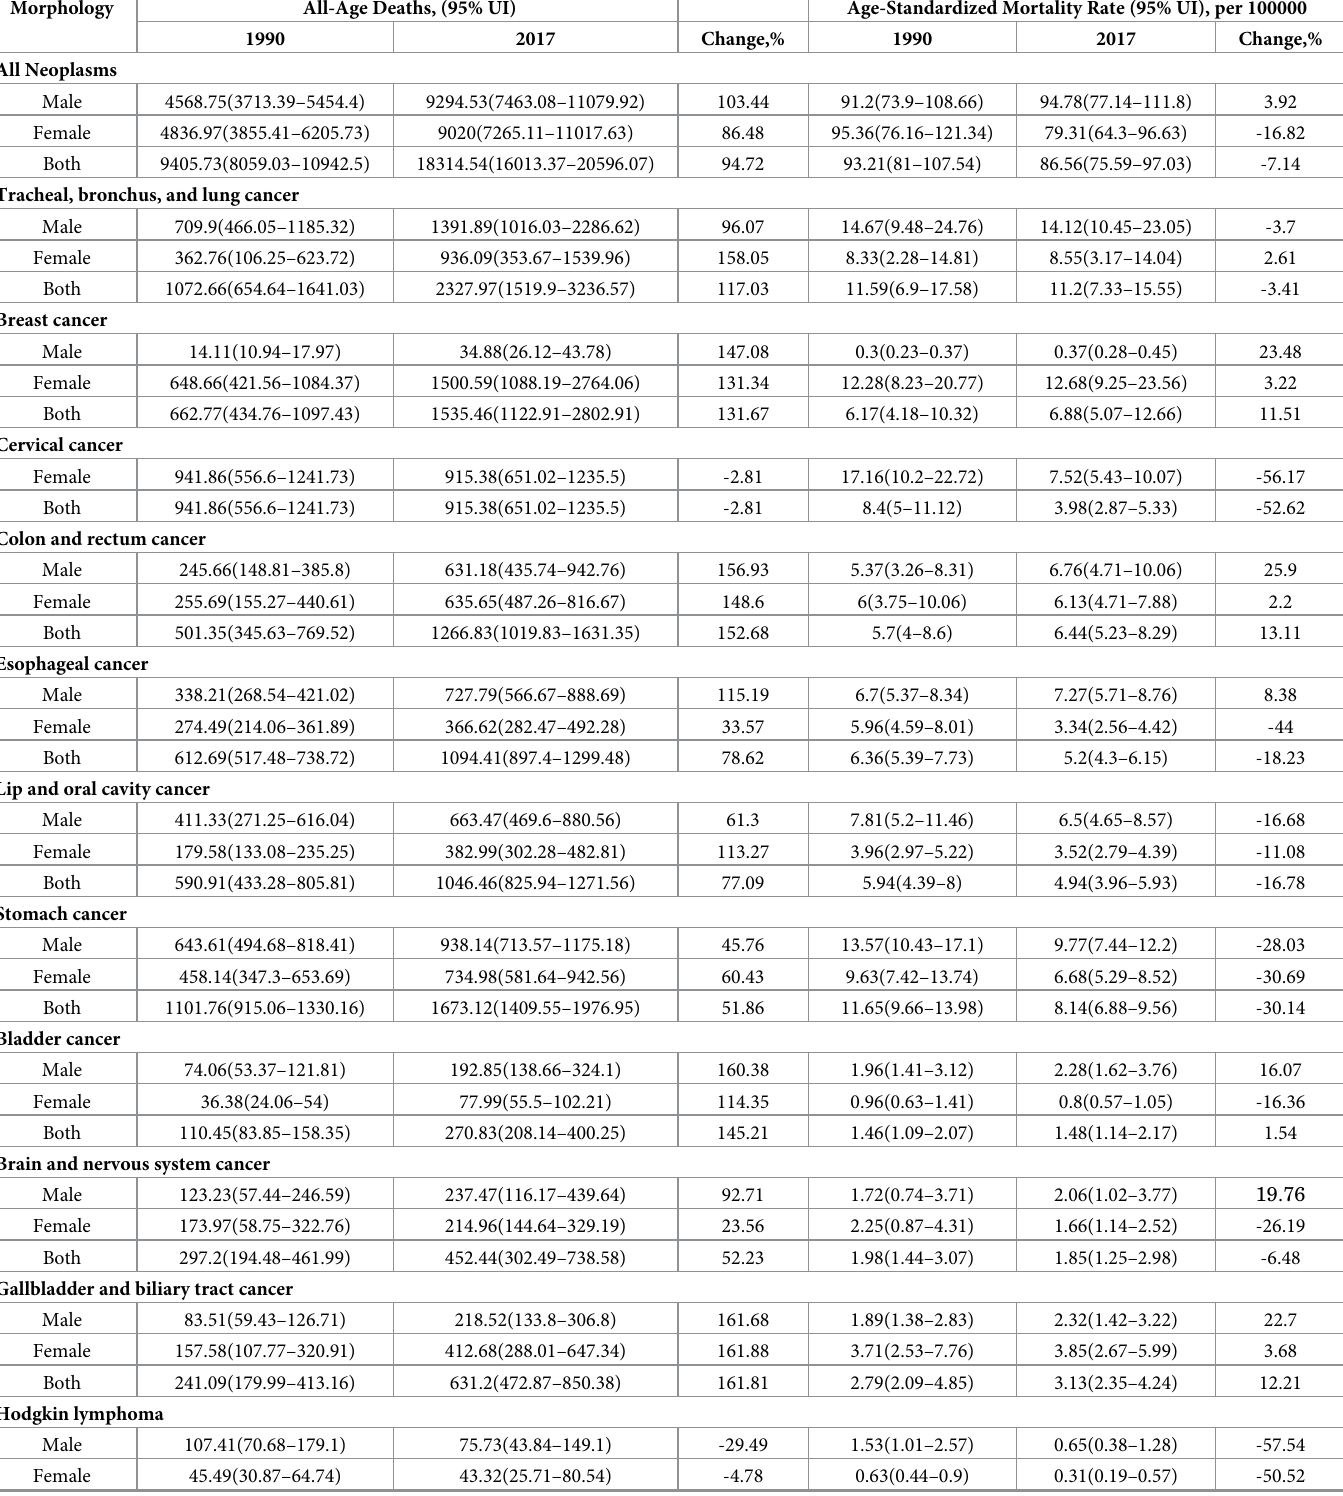
Table 4. All-age deaths and age-standardized mortality rates for different types of cancer and their percentage change by gender in Nepal, 1990–2017.